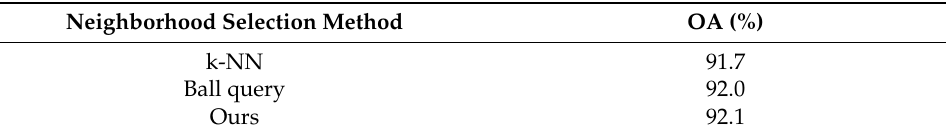
Table 3. Classification results on ModelNet40 with different neighbor selection